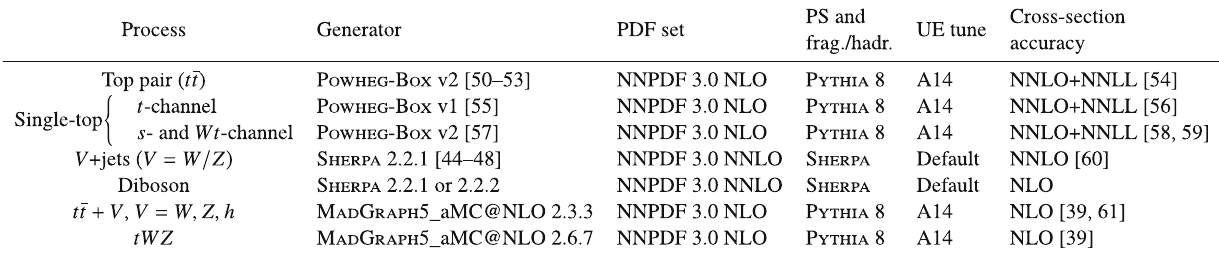
Table 1 List of generators used for the different SM background pro- cesses. Diboson includes WW , W Z and Z Z production. Information is given about the underlying-event tunes, the PDF sets and the pertur- bative QCD highest-order accuracy (LO, NLO, next-to-next-to-leading